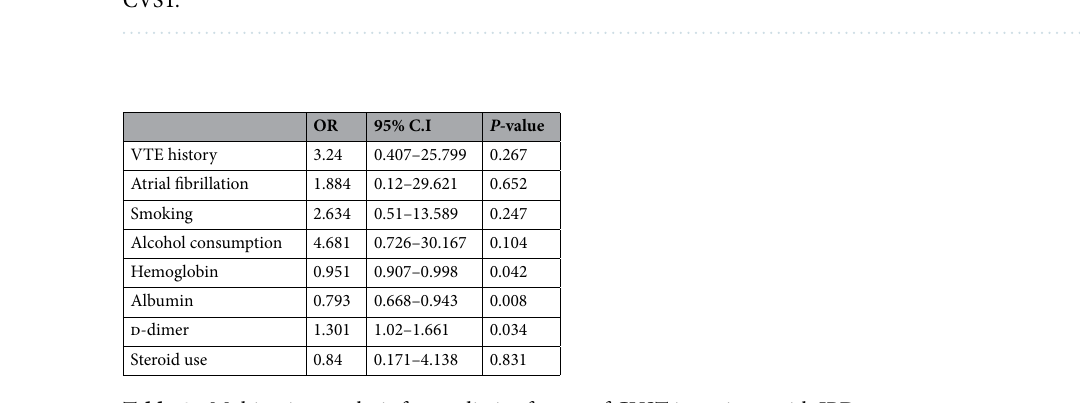
Table 4. Multivariate analysis for predictive factors of CVST in patients with